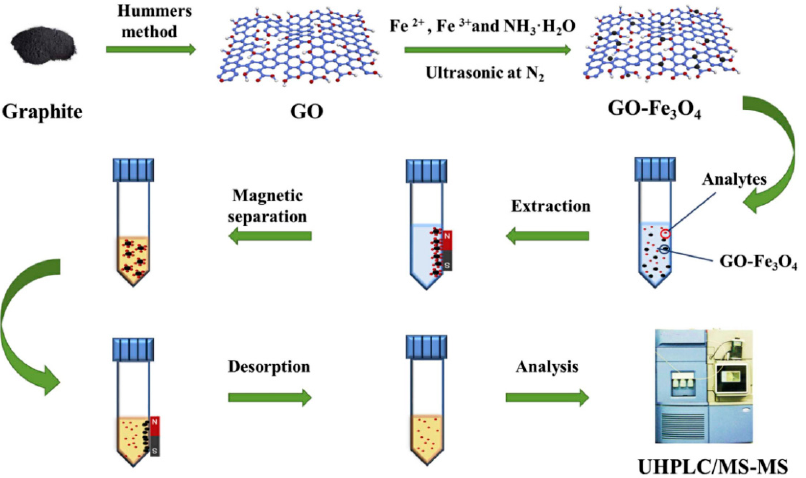
Figure 18. Schematic illustration of the synthesis of GO–Fe 3 O 4 and MSPE procedure for analysis of the eight psychoactive drugs. Reprinted with permission from Ref. [114]. Copyright (2020) Elsevier.